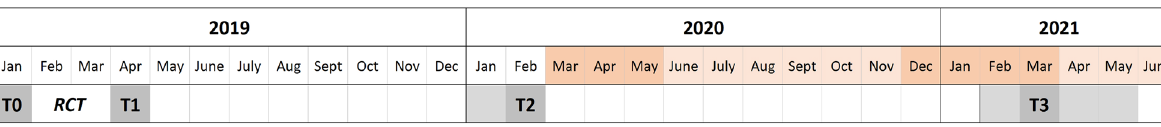
Figure 1. Timeline of the study in relation to the COVID-19 pandemic. Note. This timeline shows the timing of the study (grey) in relation to the COVID-19 pandemic (orange; dark orange depicts full school closures, while light orange depicts partial school closures). Schools first closed down on March 16th 2020. T0 (baseline), RCT (randomized controlled trial; adolescents either received a growth mindset intervention or control intervention), T1 (direct-post), T2 (1-year follow-up; pre-pandemic) and T3 (2-year follow-up; peri-pandemic). Dark grey depicts the mean date questionnaires were received, light grey depicts the entire time period in which questionnaires were received. Resilience, coping and mindset were measured at T3. Resilience was defined as residuals of the regression between school burnout symptoms and COVID-related stress exposure,